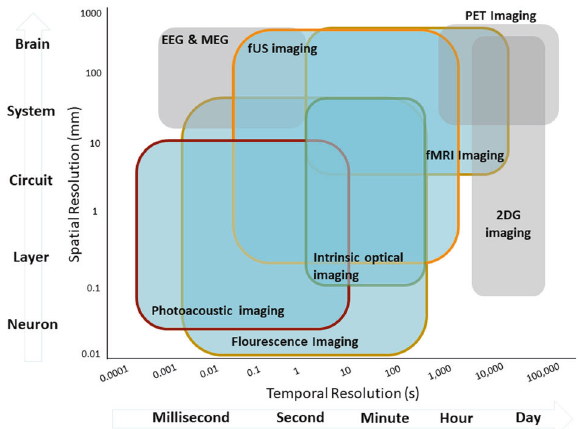
Fig. 1 The spatiotemporal overview of imaging techniques used for studying rodent whole-brain function. Each colored box represents the approximate spatiotemporal scope of the labeled technique. Light blue colored boxes represent techniques covered in this review, while gray boxes techniques are not covered. EEG electroencephalography, MEG magnetoencephalography, PET posi- tron emission tomography, 2-DG 2-deoxyglucose, fUS functional ultrasound, fMRI functional magnetic resonance Functional MRI . Functional magnetic resonance imaging (fMRI) is one of the leading techniques to study whole-brain function in humans. Its fi rst description dates back to the early 1990s, when Ogawa and colleagues [7] described the principles of blood oxygen level-dependent (BOLD) magnetic resonance imaging